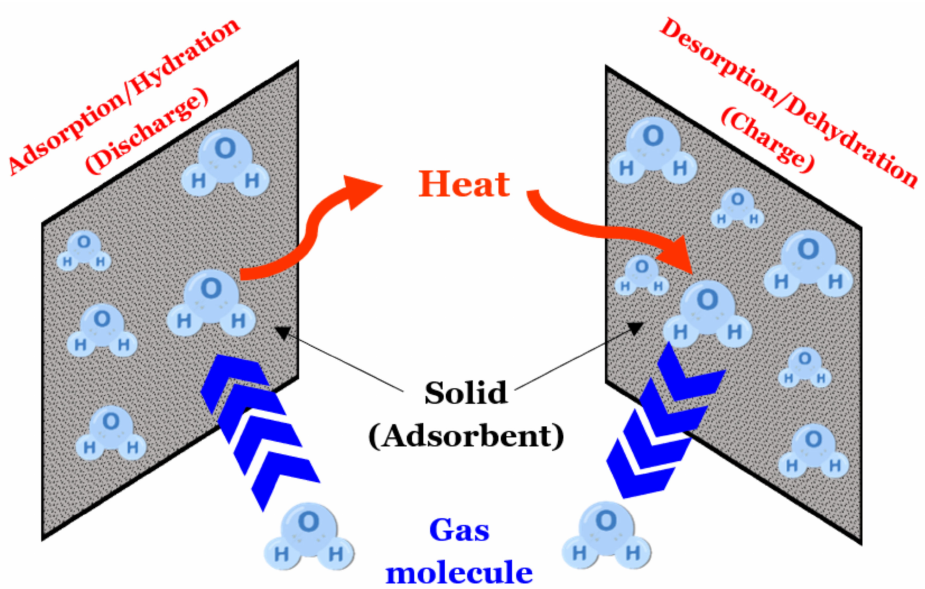
Figure 4. TCES principle of sorption (charge and